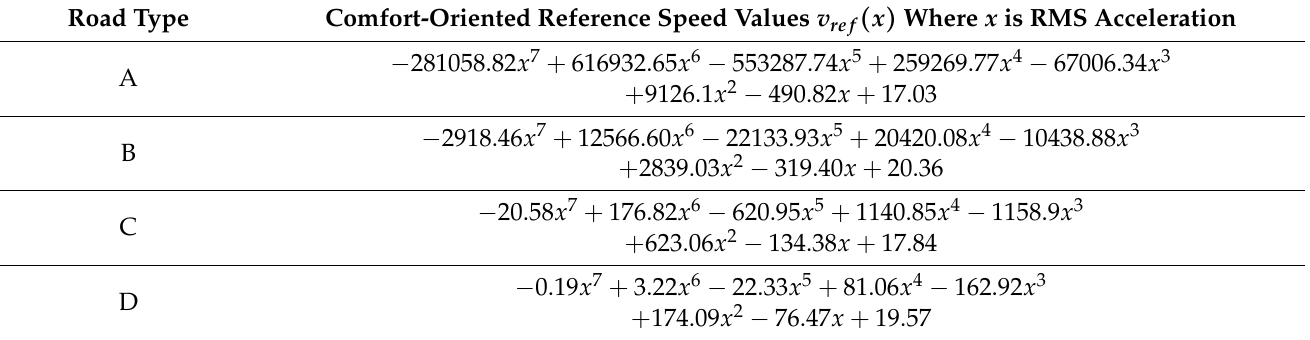
Table 4. Calculation of comfort-oriented reference speed